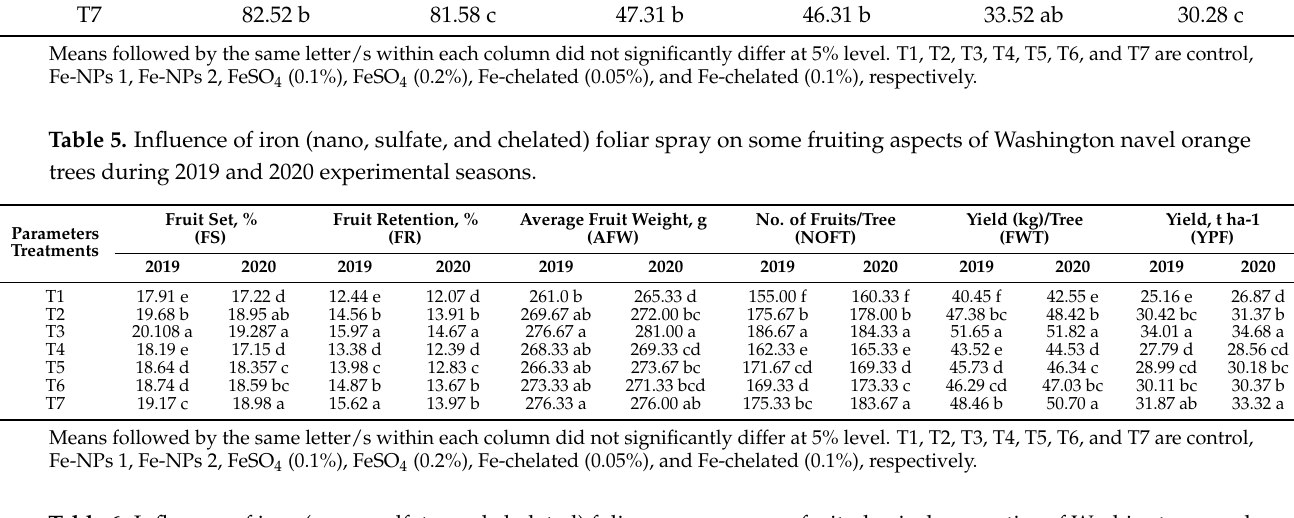
Table 6. Influence of iron (nano, sulfate, and chelated) foliar spray on some fruit physical properties of Washington navel orange trees during 2019 and 2020 experimental